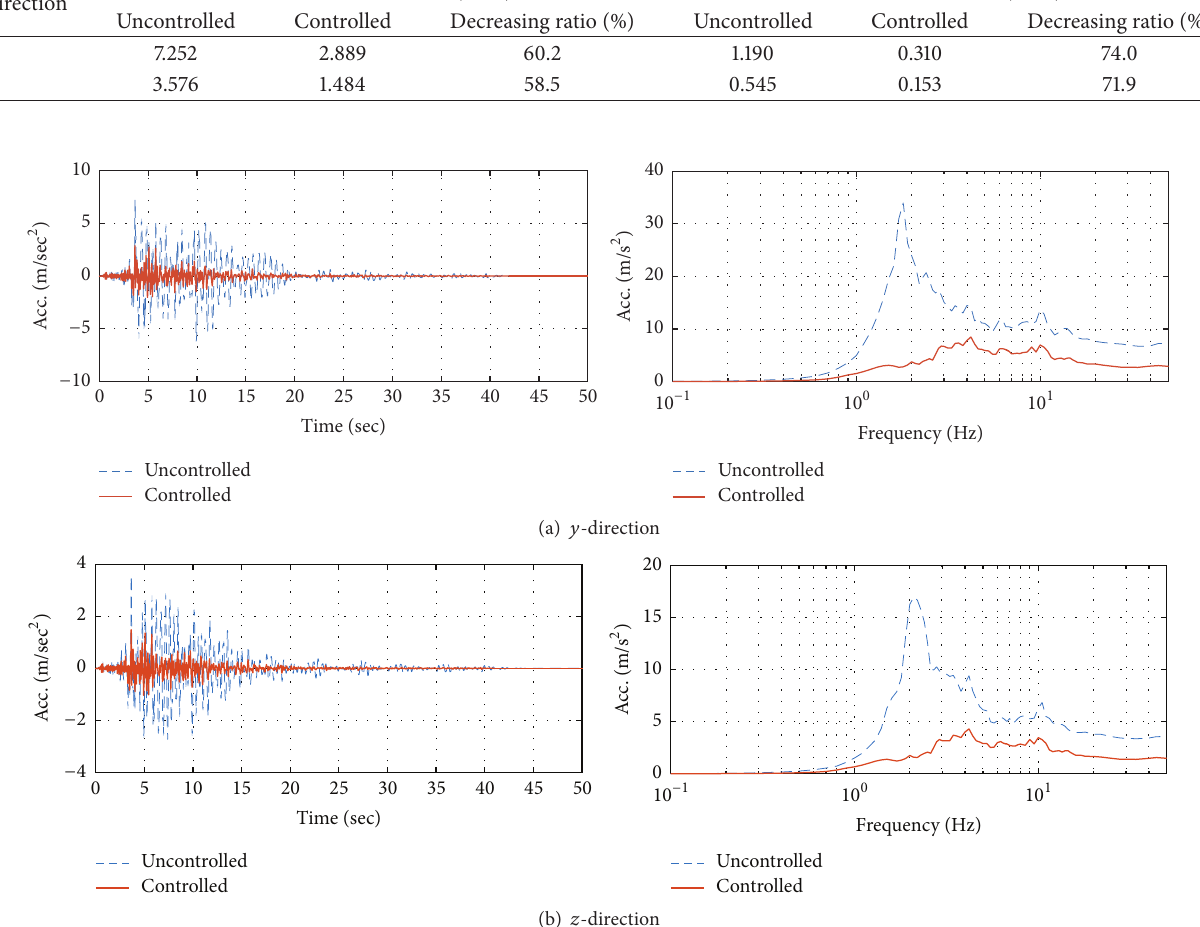
Figure 16: Response of piping system subjected to Northridge